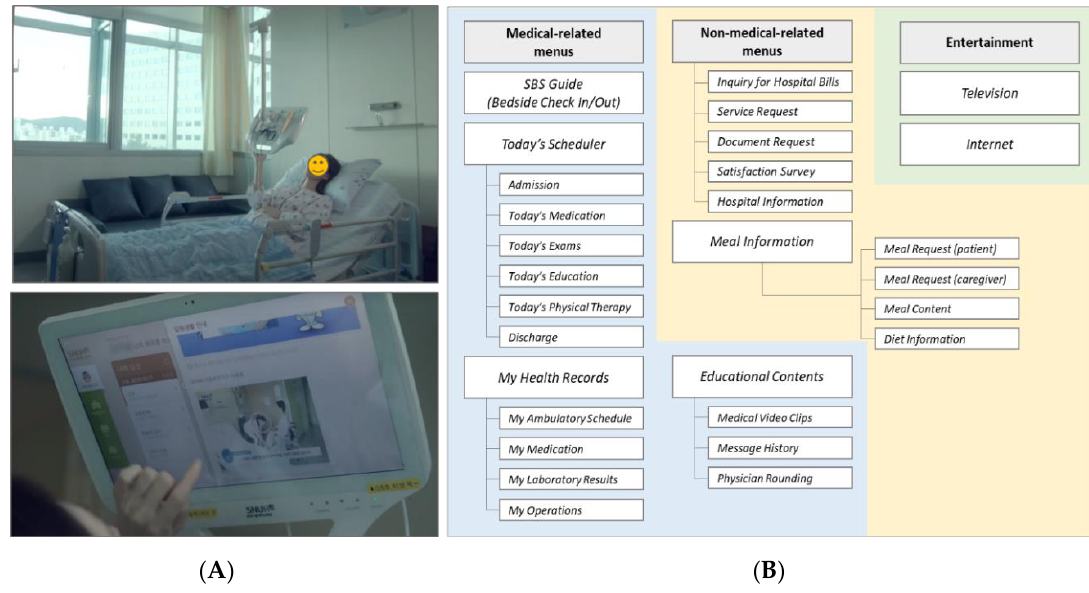
Figure 1. ( A ) Screenshots of using the Smart Bedside Station (SBS) (available from the website of the Seoul National University Bundang Hospital, http://www.snubh.org) and ( B ) key menus on the SBS (medical-related, non-medical-related and entertainment).